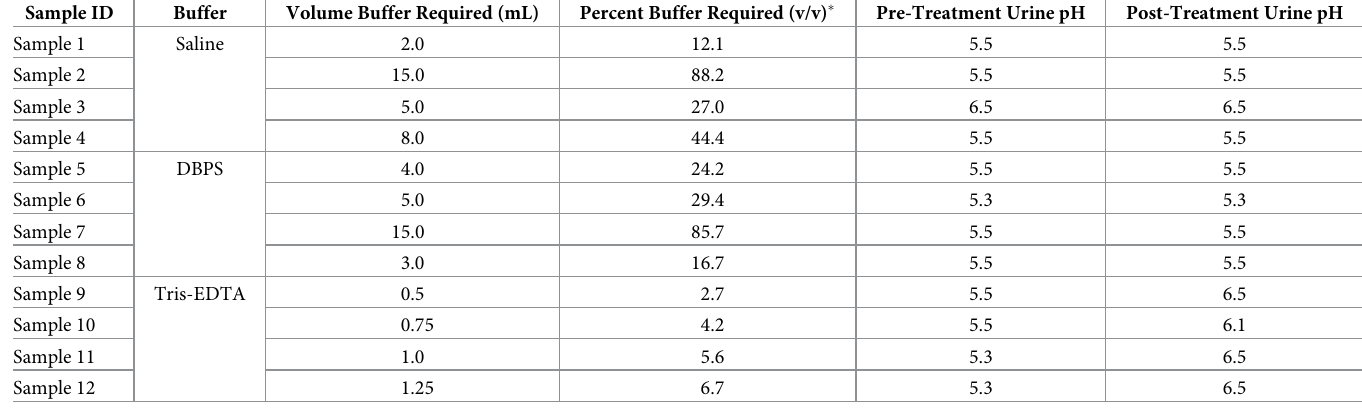
Table 1. Volume of buffer required to dissolve urine crystals and urine pH pre- and post-treatment.